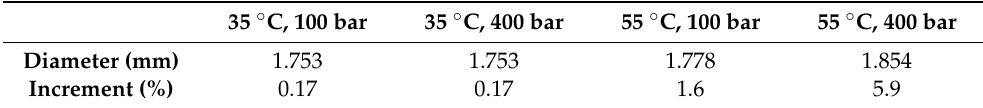
Table 4. Diameter of the MLE-impregnated PLA